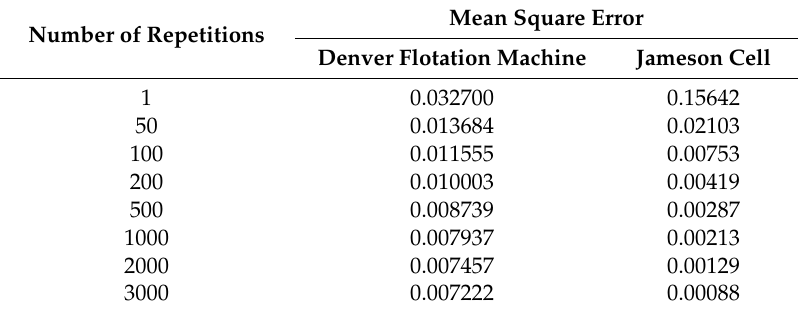
Table 8. The evaluation of matching the model generated by the neural network depending on the number of repetitions used for two flotation